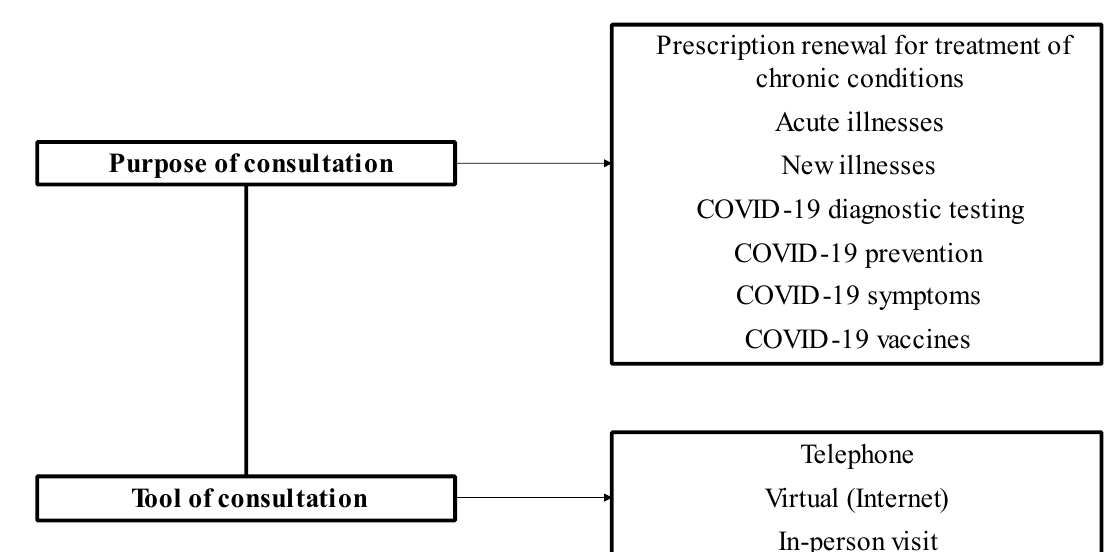
family Figure 1. The model for the study of consultations provided by physicians working in teams of family physicians.